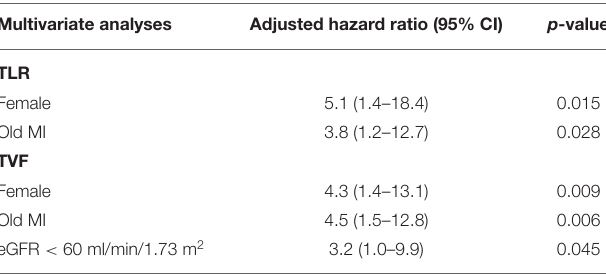
TABLE 4 | Results of multivariate cox proportional hazard models for factors associated with long-term TLR and TVF. Multivariate